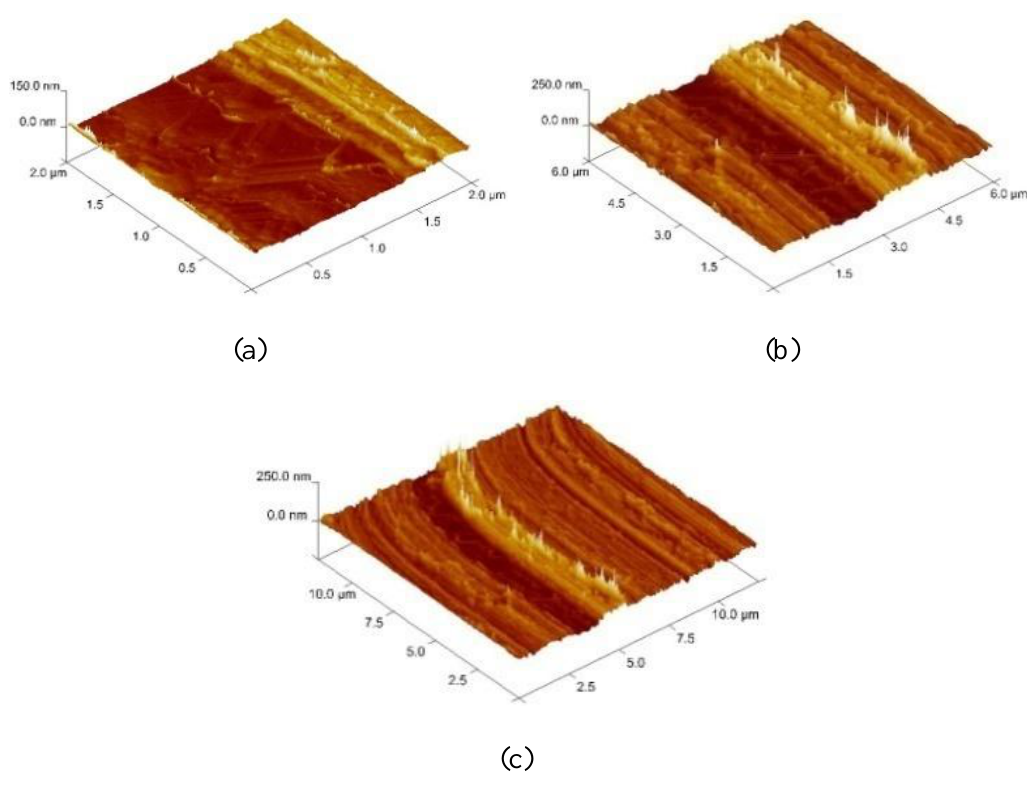
Figure 6. Three dimensional Friction images for different scan sizes for K68 uncoated carbide inserts of (a) 2 μm; (b) 6 μm and (c) 12